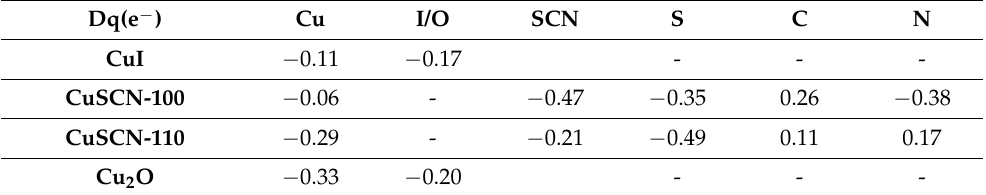
Table 1. Change in the Bader charges ( ∆ q in e − ) upon formation of the copper vacancy in CuI, CuSCN and Cu 2 O surfaces. All entries indicate the total cumulative charge change in the corresponding